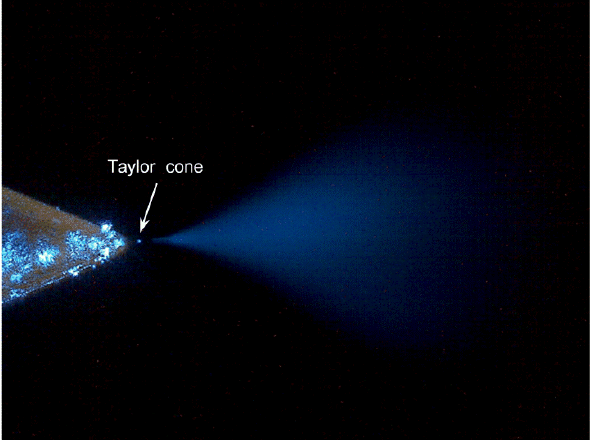
Figure 5. Image of the laser-illuminated electrospray: this is a frame captured from video footage of the electrospray plume generated from the corner integrated emitter